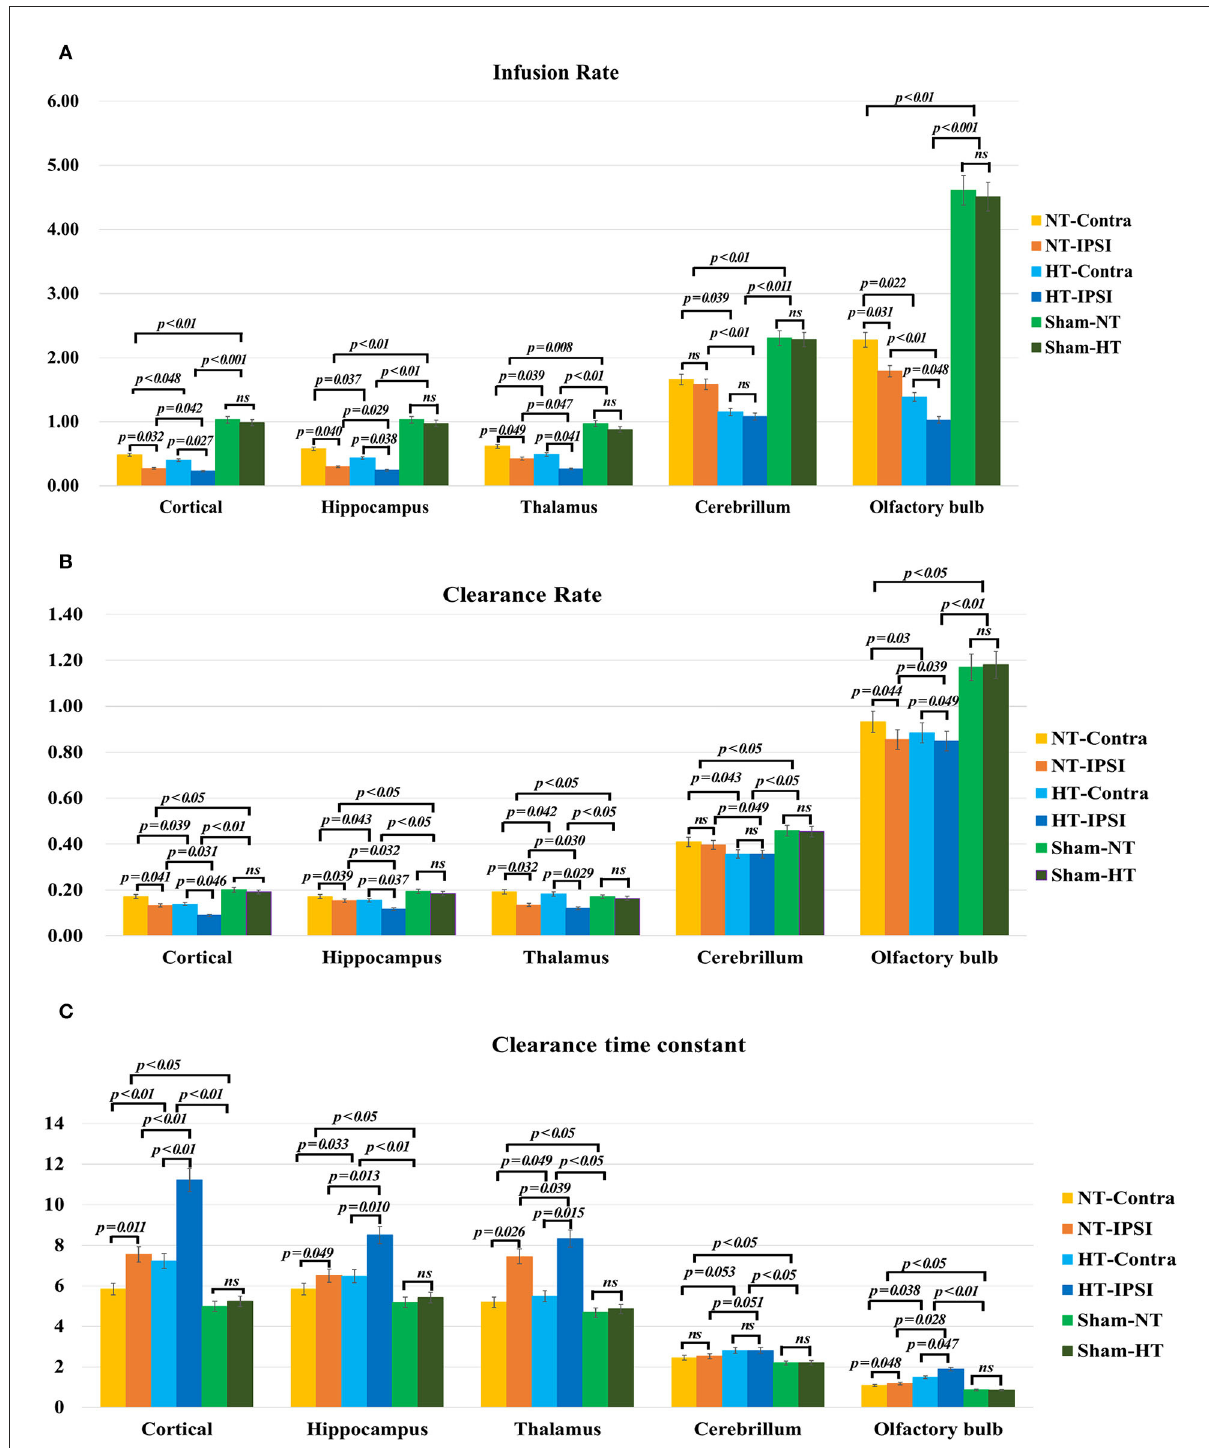
FIGURE9 The quantitative analysis derived from TICs regarding the influence of TBI and hypothermia treatment on the glymphatic influx of low weight molecular contrast agent. Group comparison of infusion rate (A) , clearance rate (B) , and clearance time constant (C) in examined bilateral brain subregions, including ipsilateral and contralateral cortex, ipsilateral and contralateral hippocampus, ipsilateral and contralateral thalamus, ipsilateral and contralateral cerebellum, and ipsilateral and contralateral olfactory bulb. Within the major experimental period, a significant lower infusion and clearance rate and larger clearance time constant is detected in all brain subregions in the TBI-HT group, compared to the TBI-NT group, and in the TBI-NT group, compared to both Sham-NT and Sham-HT groups. Similar results are also found in all ipsilateral subregions except cerebellum in both TBI-HT and TBI-NT groups, compared to the contralateral subregions, but not in sham injury groups. Data in (A–C) :